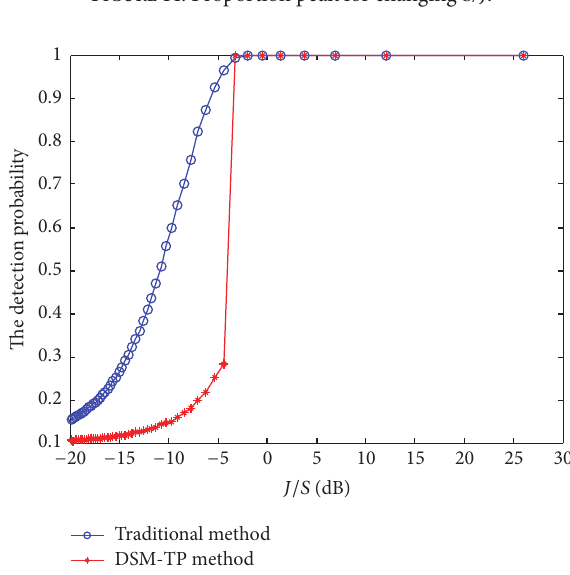
Figure 14: Proportion peak for changing S/J .